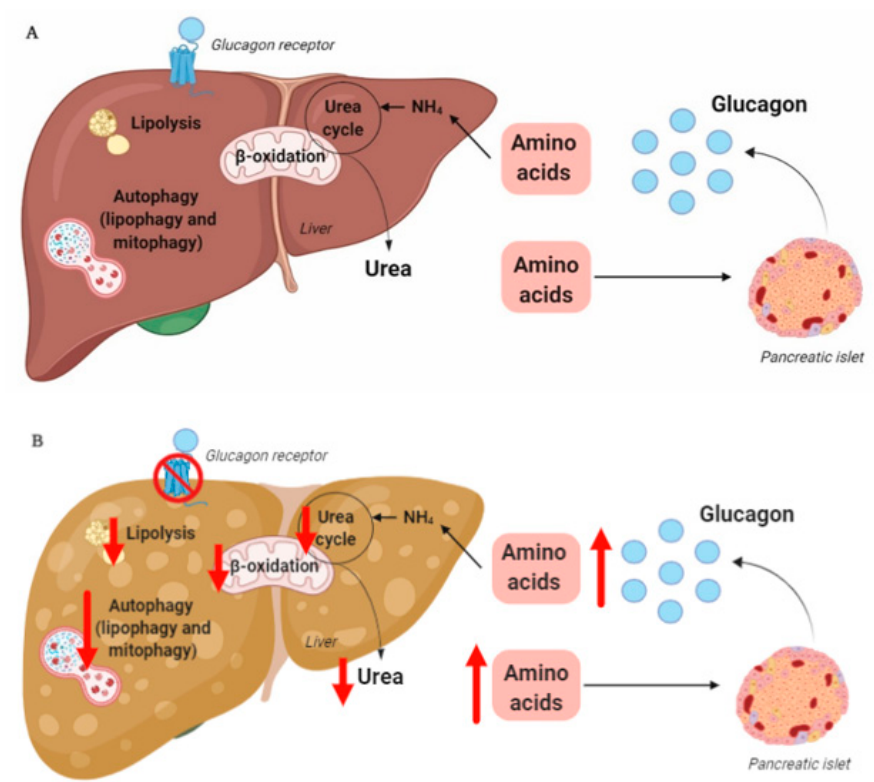
Figure 1. ( A ) Glucagon is secreted from the pancreatic alpha-cell and binds to its hepatic receptor. This results in increased hepatic amino acid uptake and metabolism (ureagenesis). Hepatic glucagon signaling also increases lipolysis and ß-oxidation and may increase hepatic autophagy. ( B ) During conditions of disrupted glucagon signaling, hepatic amino acid metabolism and ureagenesis is halted, as is hepatic lipolysis, ß-oxidation, and autophagy. This results in the accumulation of hepatic fat and damaged organelles, inducing oxidative stress and increased plasma amino acids, leading to hyperglucagonemia. This figure was created using BioRender.